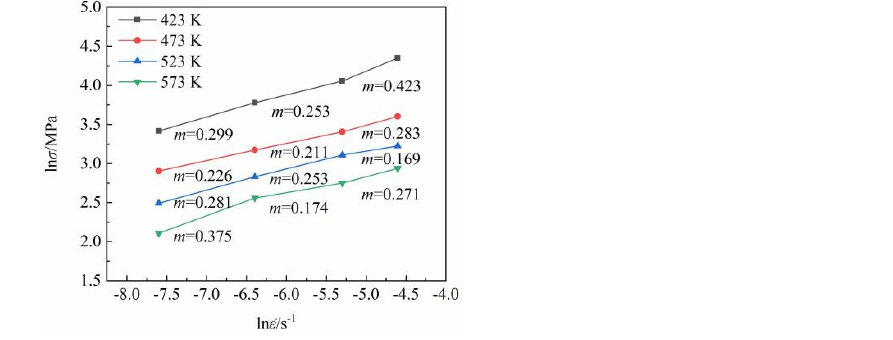
Figure 6. The strain rate sensitivity index (m value) under different conditions: Log true stress–log strain rate curves.